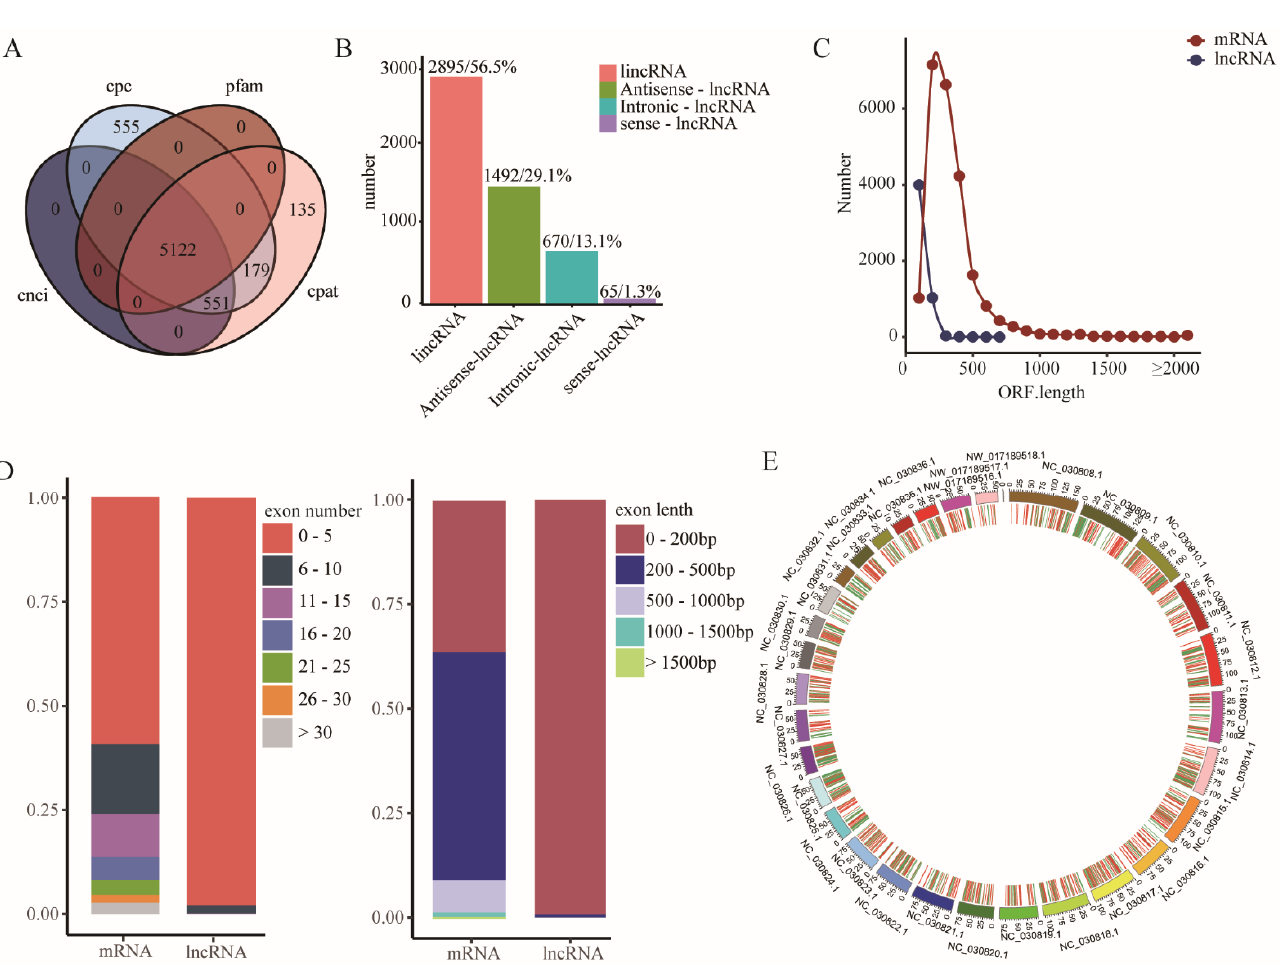
Figure 3. Identification of lncRNAs in goat muscles. ( A ) Prediction method Venn diagram. ( B ) Sta- tistics of the number of four different types of lncRNAs. ( C ) ORF length distribution of mRNA and lncRNA. ( D ) Statistical of exon number and length. ( E ) Distribution of the identified lncRNA and mRNA in the chromosome.